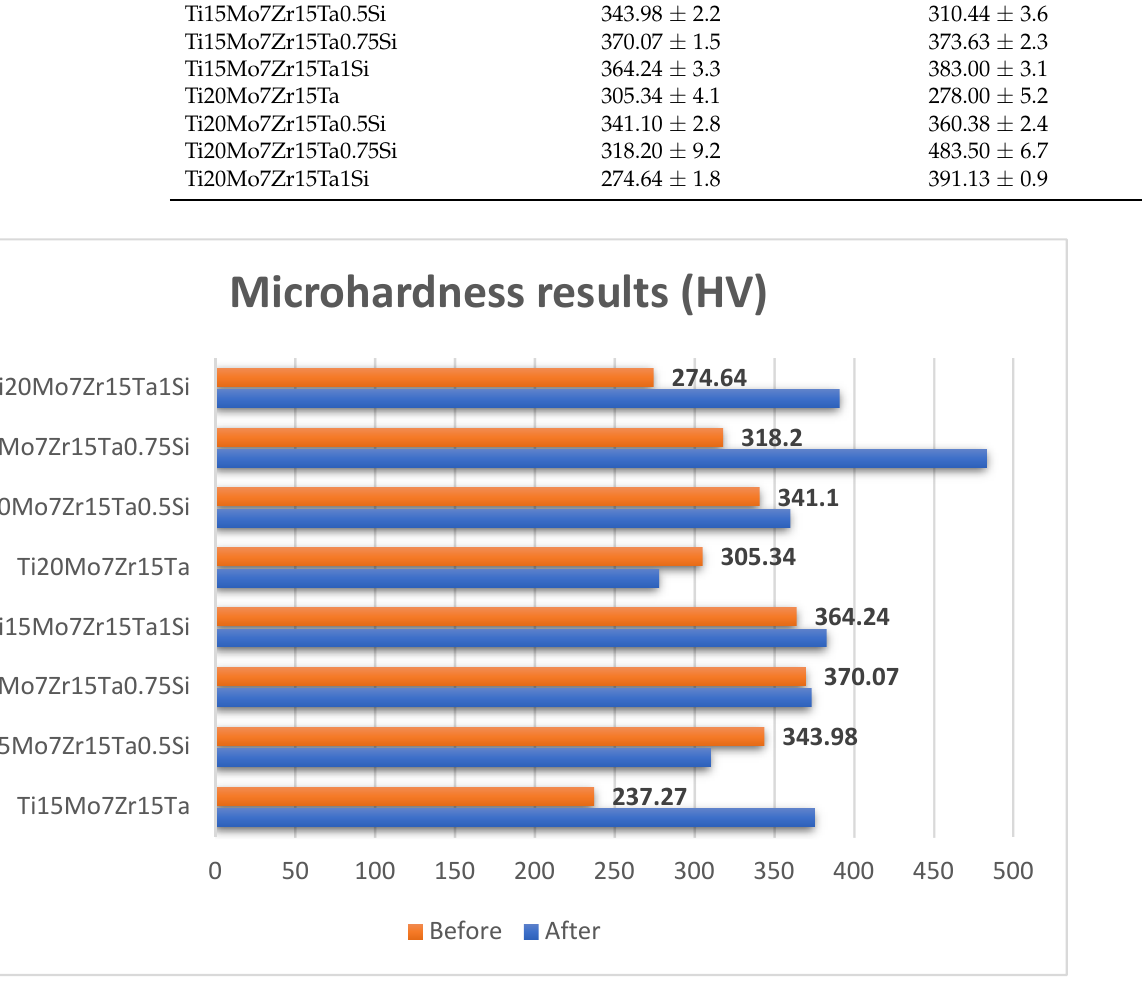
Figure 7. Hardness comparison (before and after the thermal treatment).